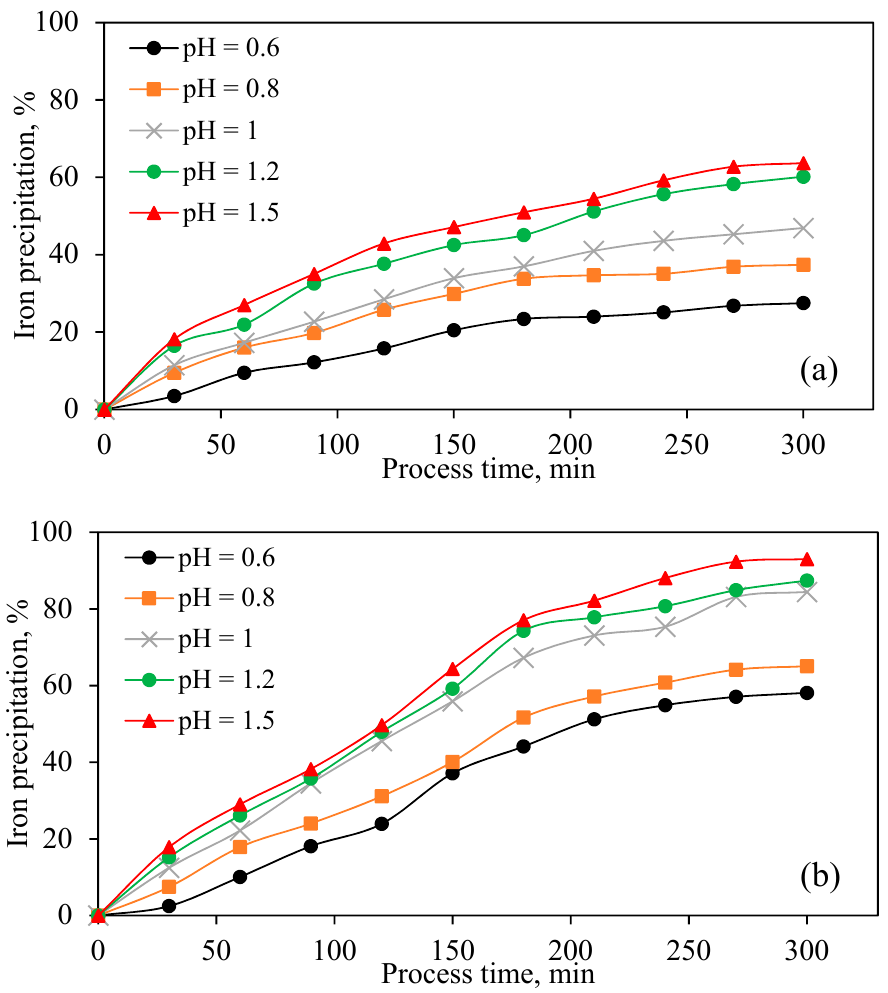
Figure 6. Effect of ( a ) initial pH and ( b ) constant pH on iron precipitation (Temperature = 90 °C, [Na 2 SO 4 ] = 2 g/L, Stirring speed = 600 RPM).